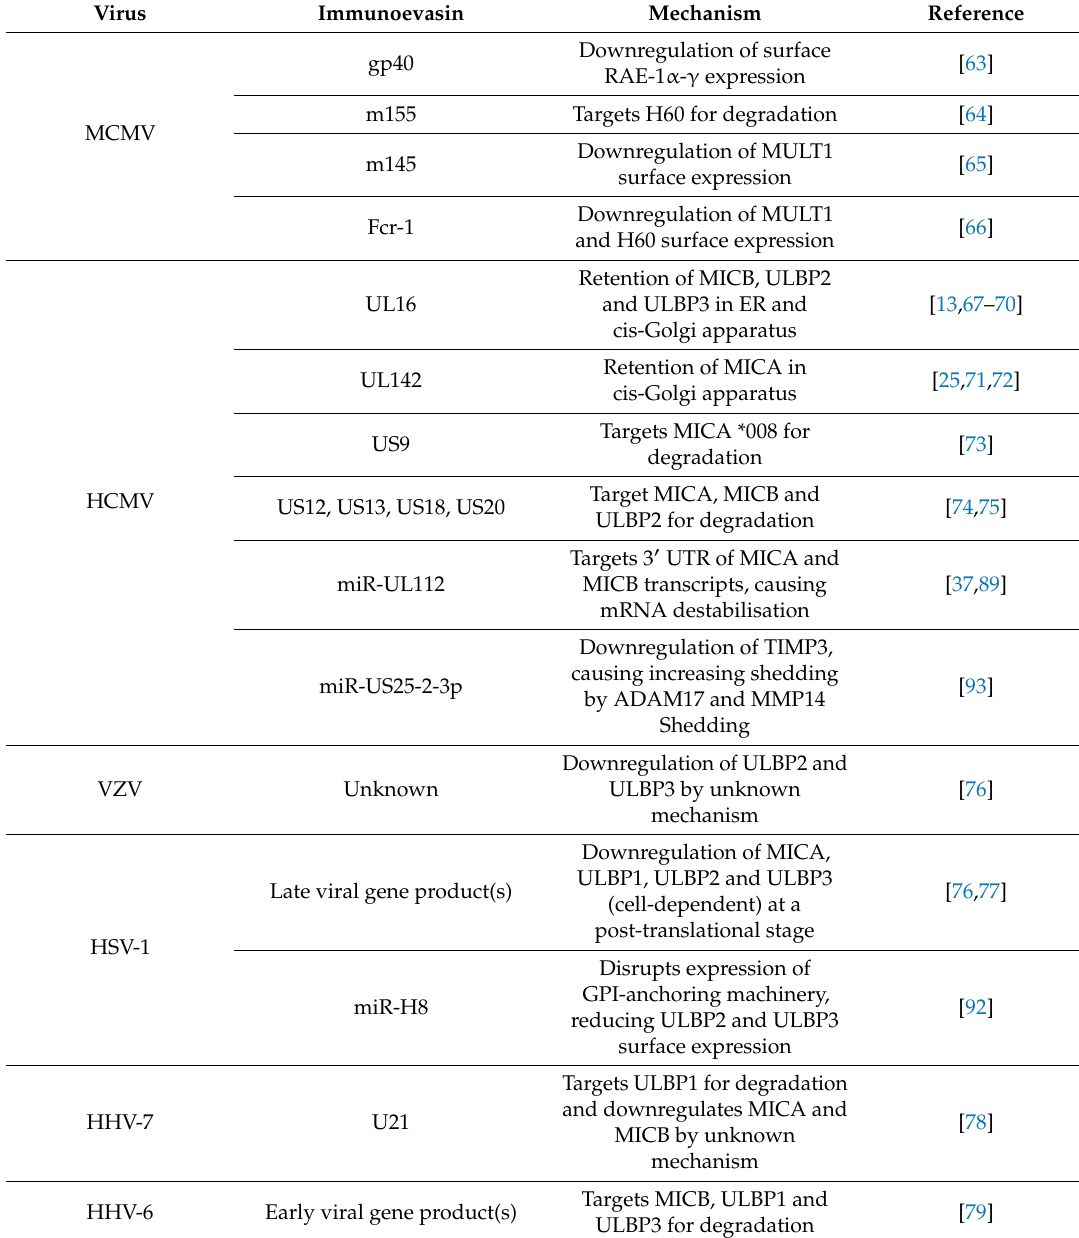
Table 1. Summary of viral mechanisms of NKG2D immune